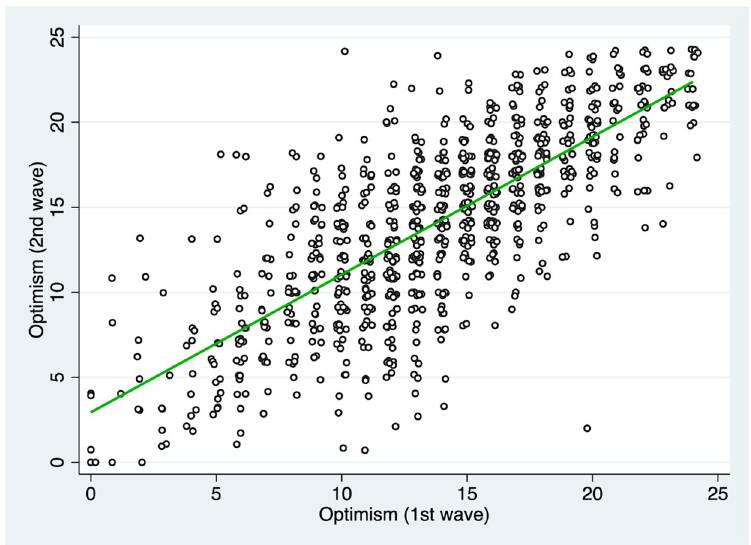
Fig 2. Stability of optimism over time. Note: The figure illustrates the relationship between optimism in the first survey wave (June 2020) and the second wave (May 2021). The dots represent the observations whereas the green line is the linear